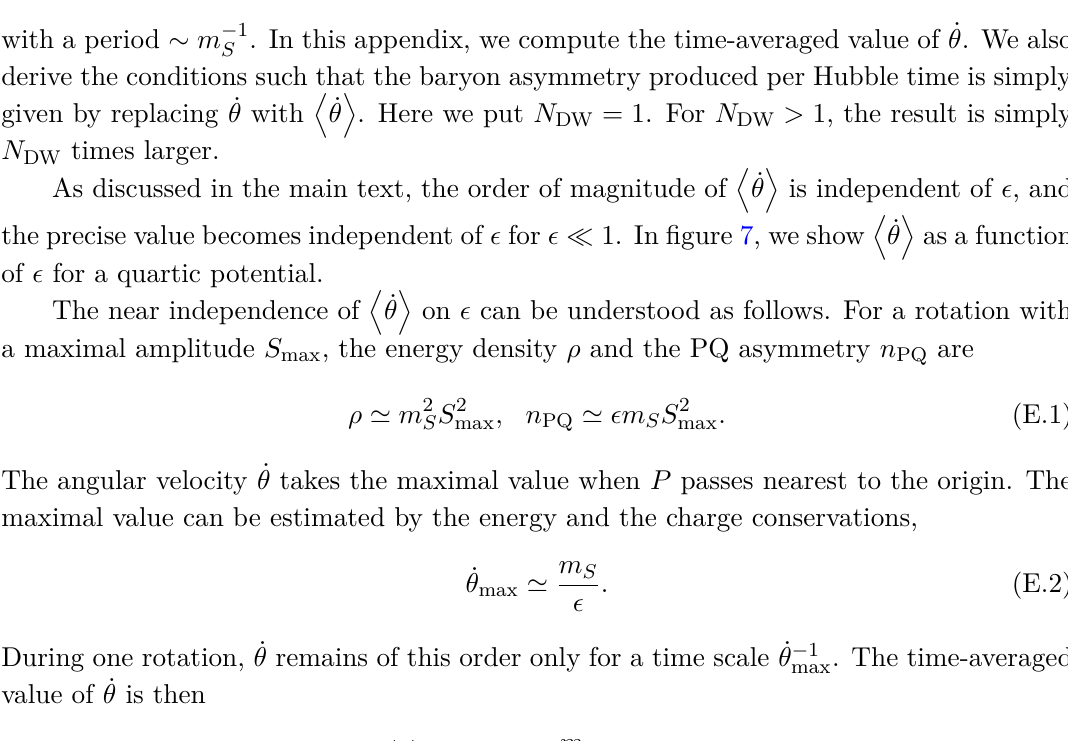
Figure 7 . The time average of ˙ θ as a function of (cid:15) for the quartic potential, normalized to ˙ θ for a pure rotation ( (cid:15) = 1